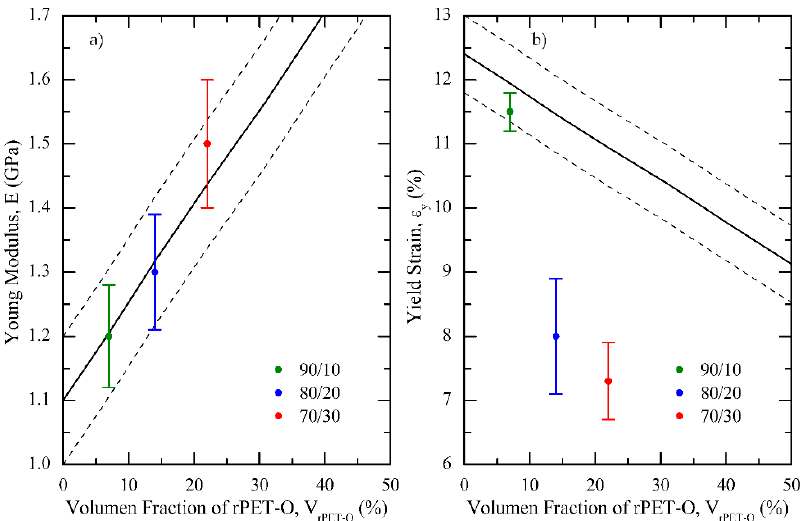
Figure 8. Predicted values by the additive rule of mixtures (ARM) (solid line) and its standard deviation (dashed lines) for ( a ) Young’s modulus (E) and ( b ) yield strain ( ε y ) of rPP/rPET-O samples tested at 1 mm·min − 1 .